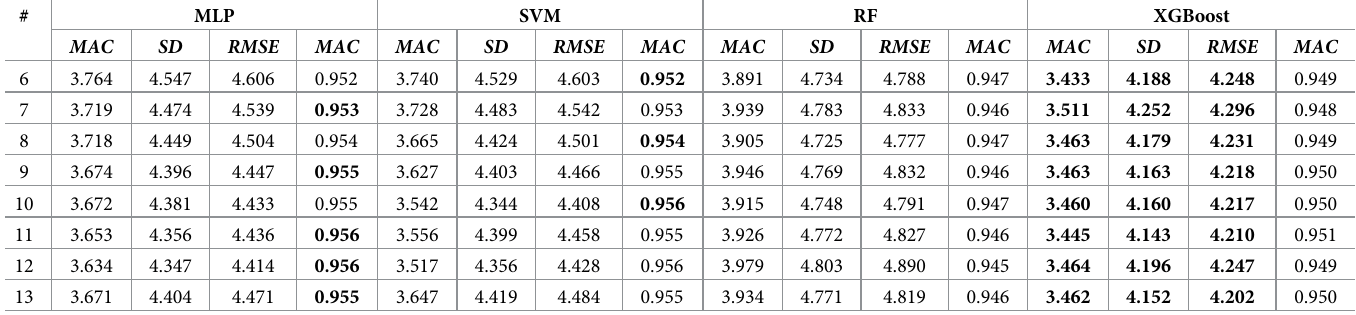
Table 5. Experimental results for the MLP, SVM, RF, and XGBoost, based on the StatLib dataset, with FA feature extraction (best results are highlighted in bold; # means the number of features).